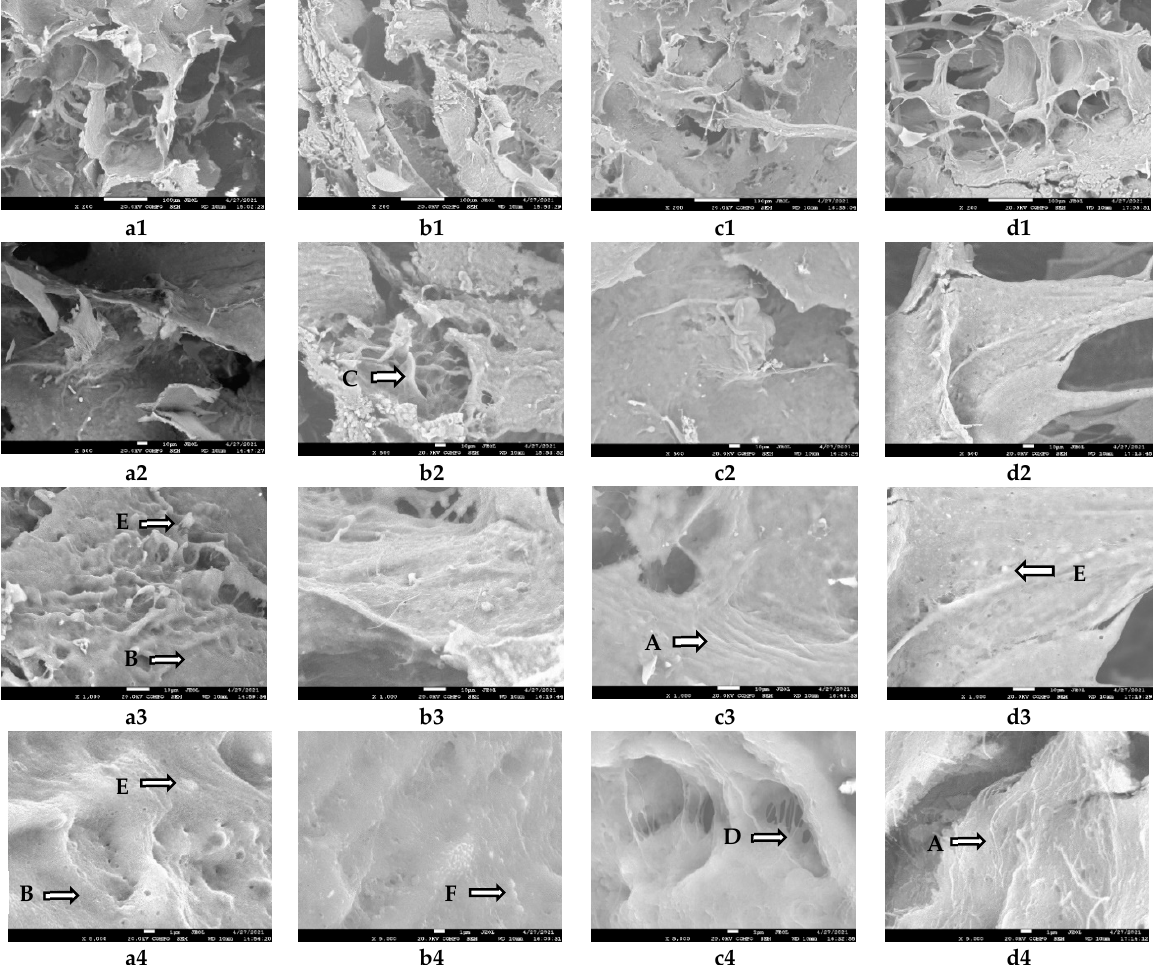
Figure 7. SEM microscopic structure of hen gizzards hydrolysates: ( a ) control sample at the start of hydrolysis; ( b ) control sample at the end of hydrolysis; ( c ) hydrolyzed test sample with Propionix LCSC; ( d ) hydrolyzed test sample with BLC; A: fibrous structure of the matrix; B: uniform and dense matrix surface; C: aggregated collagen fiber; D: thin films; E: mineral components of whey; F: globular proteins; magnification: (1) ×200, (2) ×500, (3) ×1000, (4) ×5000.